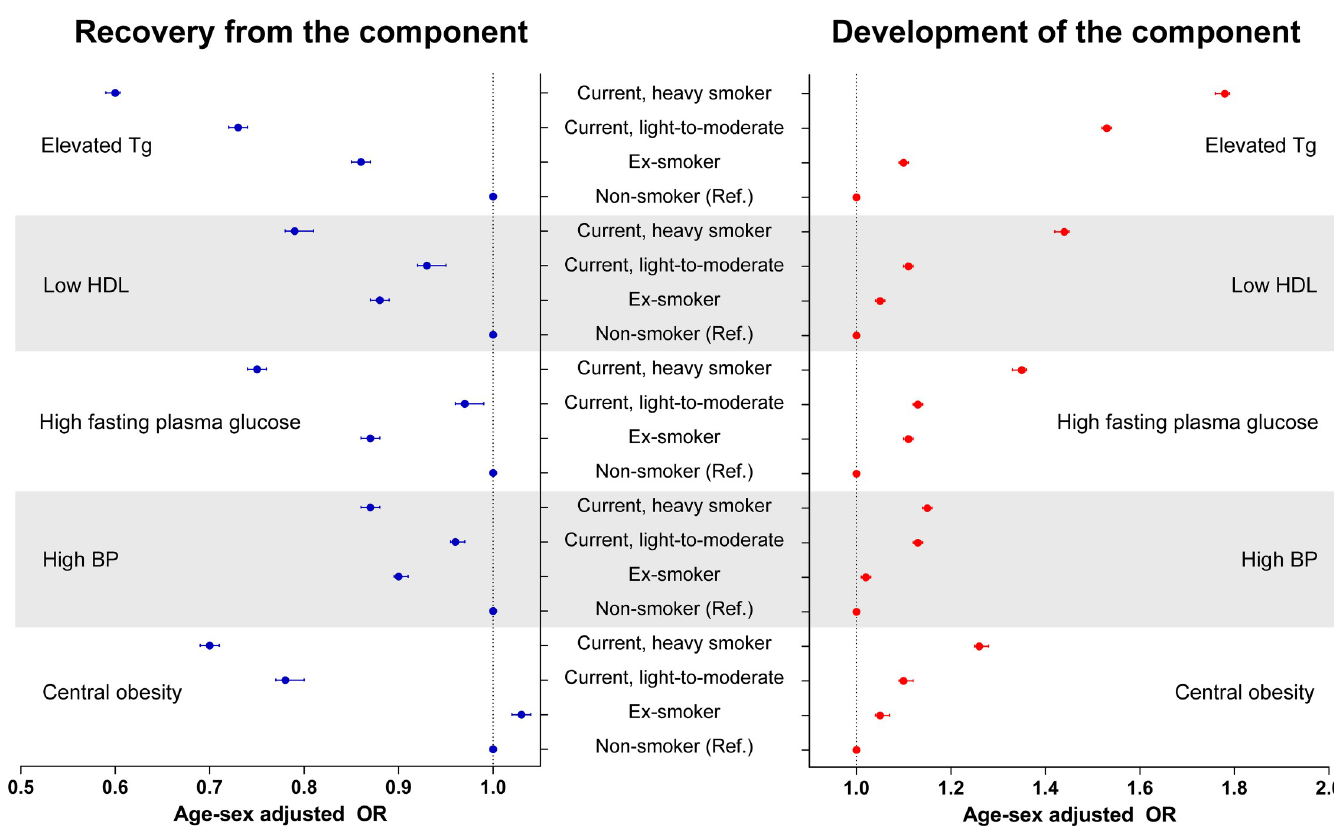
Fig 2. Association between smoking status and development of or recovery from individual MetS components. The blue dots and error bars indicate the age- and sex-adjusted odds ratios and 95% confidence intervals for recovery from the component. The red dots and error bars indicate the age- and sex-adjusted odds ratios and 95% confidence intervals for the development of the component. The recovery from individual MetS components was assessed within between individuals with the component at the first health screening (S1) and those who no longer fulfilled the criterion in the second (S2) and third (S3) health screenings were considered to be recovered from the MetS component. The development of individual MetS components was assessed between individuals without the component at S1 and those who fulfilled the criterion at S2 and S3 were considered to have developed the MetS component. All odds ratios are presented with nonsmokers used as the reference group.